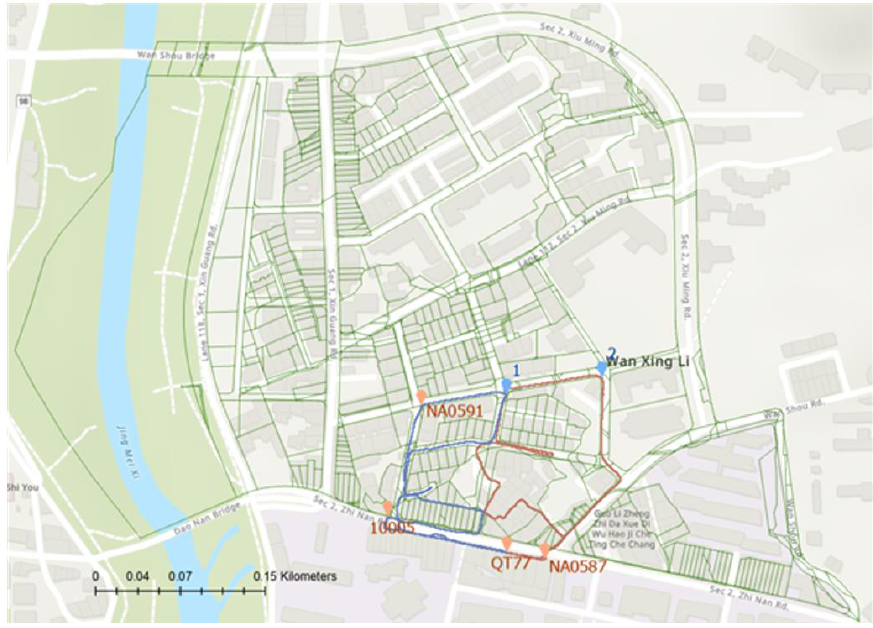
Figure 15. Two independent scanning operation areas and scanned paths. Table 10. The cadastral TWD97 coordinates and ortho-height of used control points. Point No.